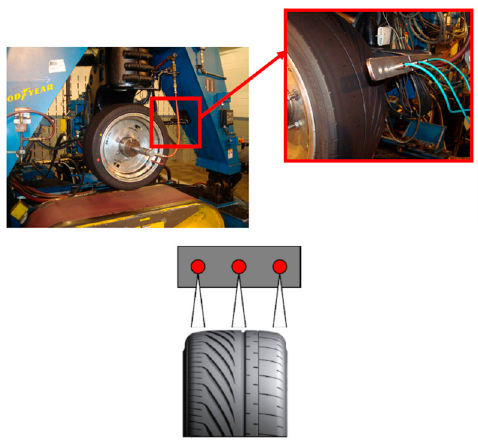
Figure 14. Tire temperature apparatus installed on the Flat-Trac® test machine.